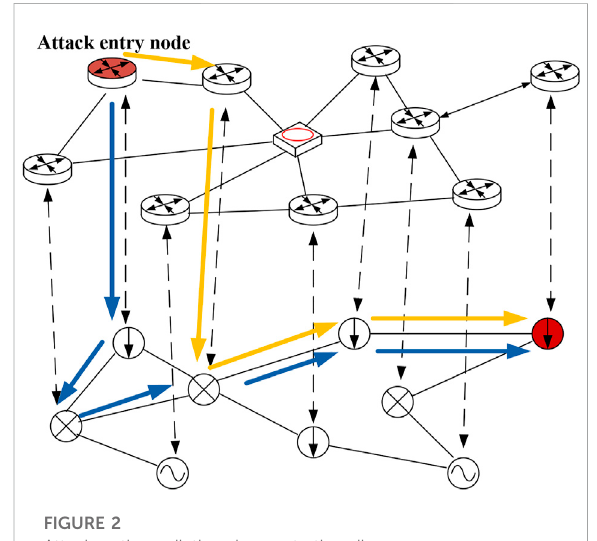
FIGURE 2 Attack-path prediction demonstration diagram.